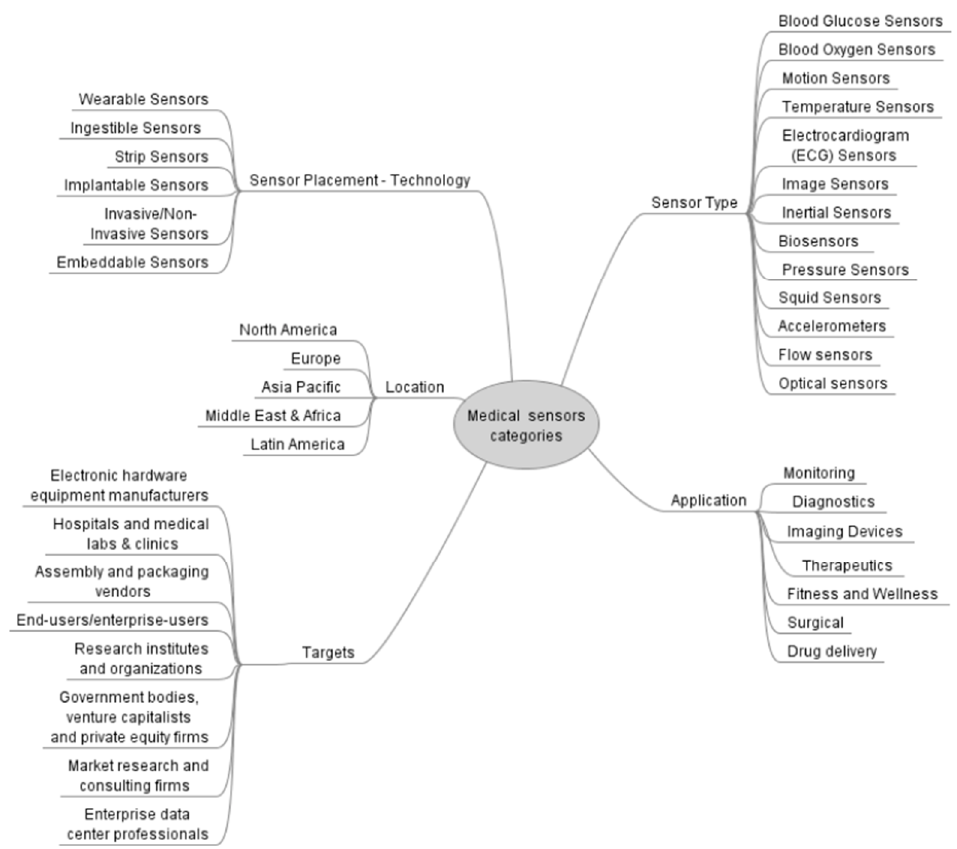
Figure 2. Medical sensor categories.